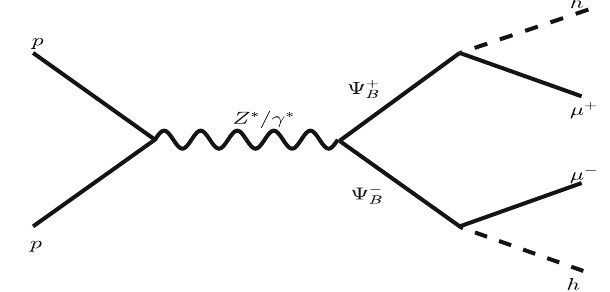
Fig. 2 Feynman diagram for the Drell–Yan productions of (cid:8) B pair at the LHC with the decay mode (cid:8) ±